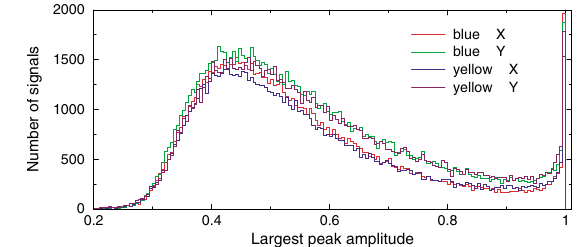
FIG. 9. (Color) Histogram of the largest peak amplitudes of all spatial modes for both planes in both rings. The Gaussian-like distributions represent a coherent signal from good BPMs and peaks at 1 represent faulty